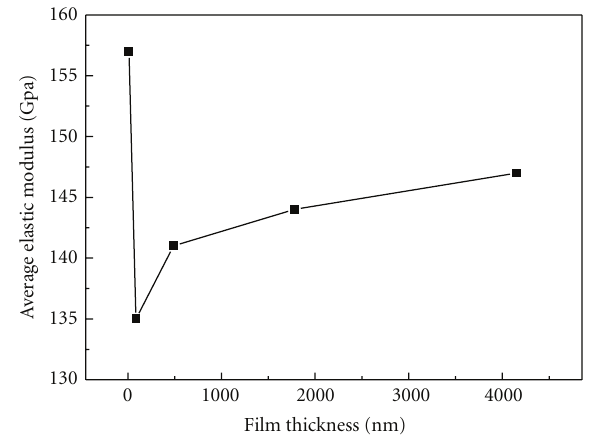
Figure 5: Nanoindentation results of the nc-Si:H films. Variation in the elastic modulus with film